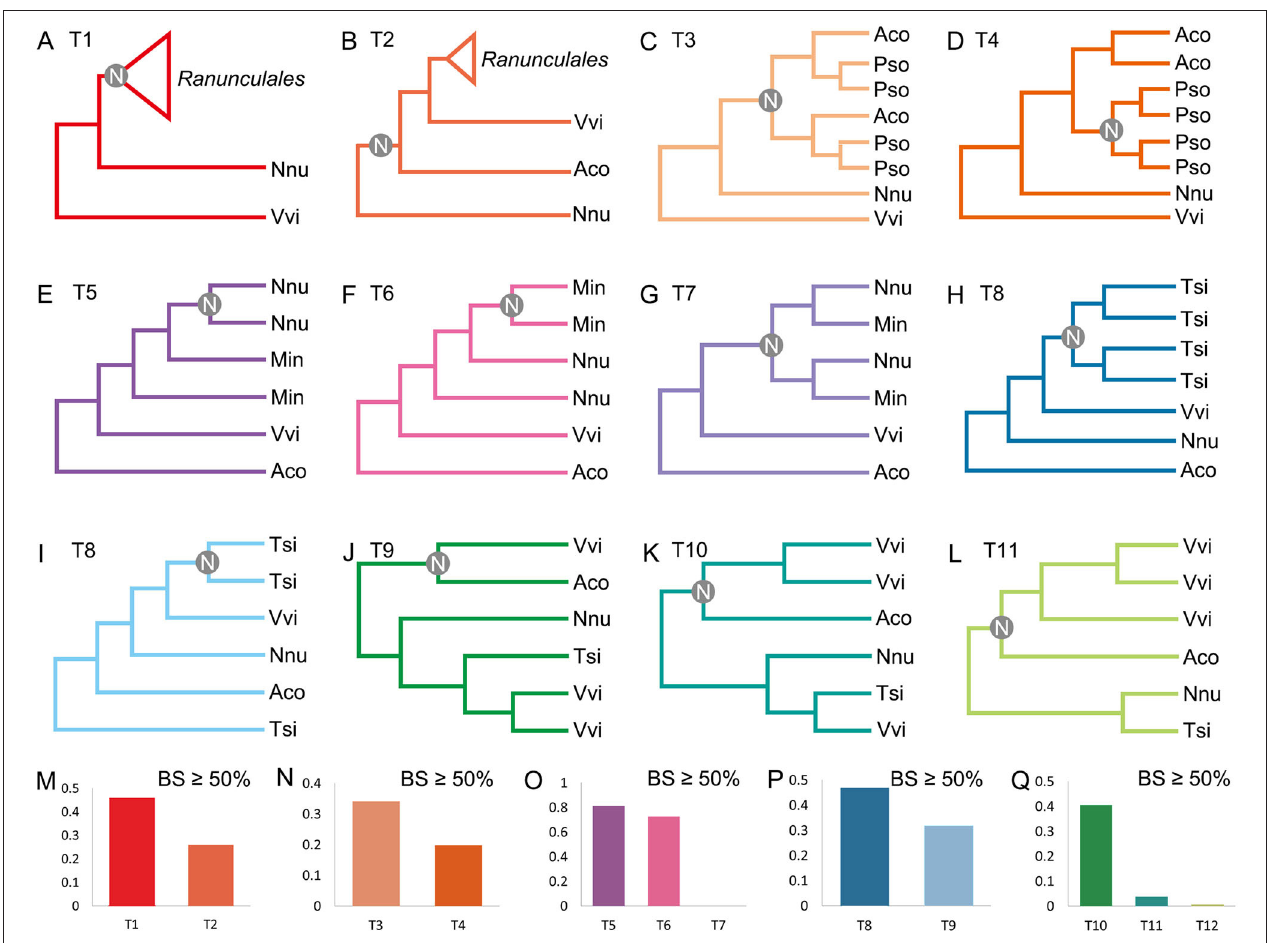
FIGURE 3 | Possible topologies of gene trees and statistics of phylogenomic analysis. Topology support (A) WGDs of Ranunculales independently of other species, (B) a WGD shared by A. coerulea and V. vinifera , (C) RCT, (D) respective WGDs of A. coerulea and P. somniferum , (E) NST, (F) MST, (G) common WGD of N. nucifera and M. integrifolia , (H) two WGDs of T. sinense , (I) only one WGD of T. sinense , (J) A. coerulea provide one paralogous gene pair to V. vinifera , (K) A. coerulea provide two paralogous gene pairs to V. vinifera , (L) A. coerulea provide three paralogous gene pairs to V. vinifera . The key nodes are indicated by gray circles. (M–Q) Gene tree frequencies for different topologies, and BS of the key node is more than 50%. Ranunculales represents genes from species of Ranunculales, and Aco, Pso, Vvi, Nnu, Min, and Tsi represent genes from the genomes of A. coerulea , P. somniferum , V. vinifera , N. nucifera , M. integrifolia, and T. sinense , respectively. The x -axis labels T1 to T12 refer to the support for the topologies.